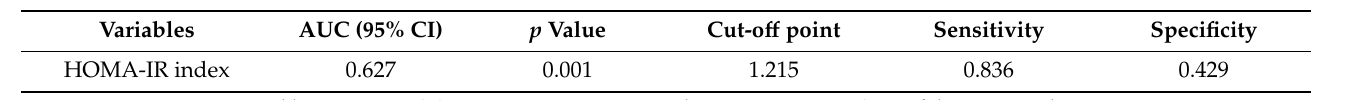
Table 4. The areas under the ROC curve (AUC), sensitivity, and specificity of the optimized cut-o ff points for the HOMA-IR index in predicting high FRS (FRS ≥